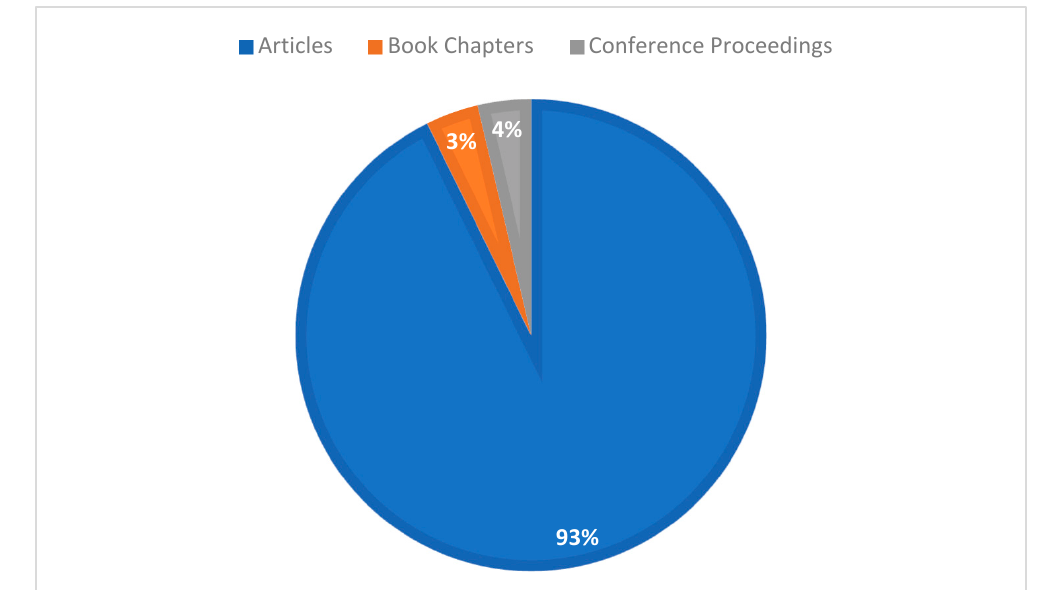
Figure 5. Publication types in the study.